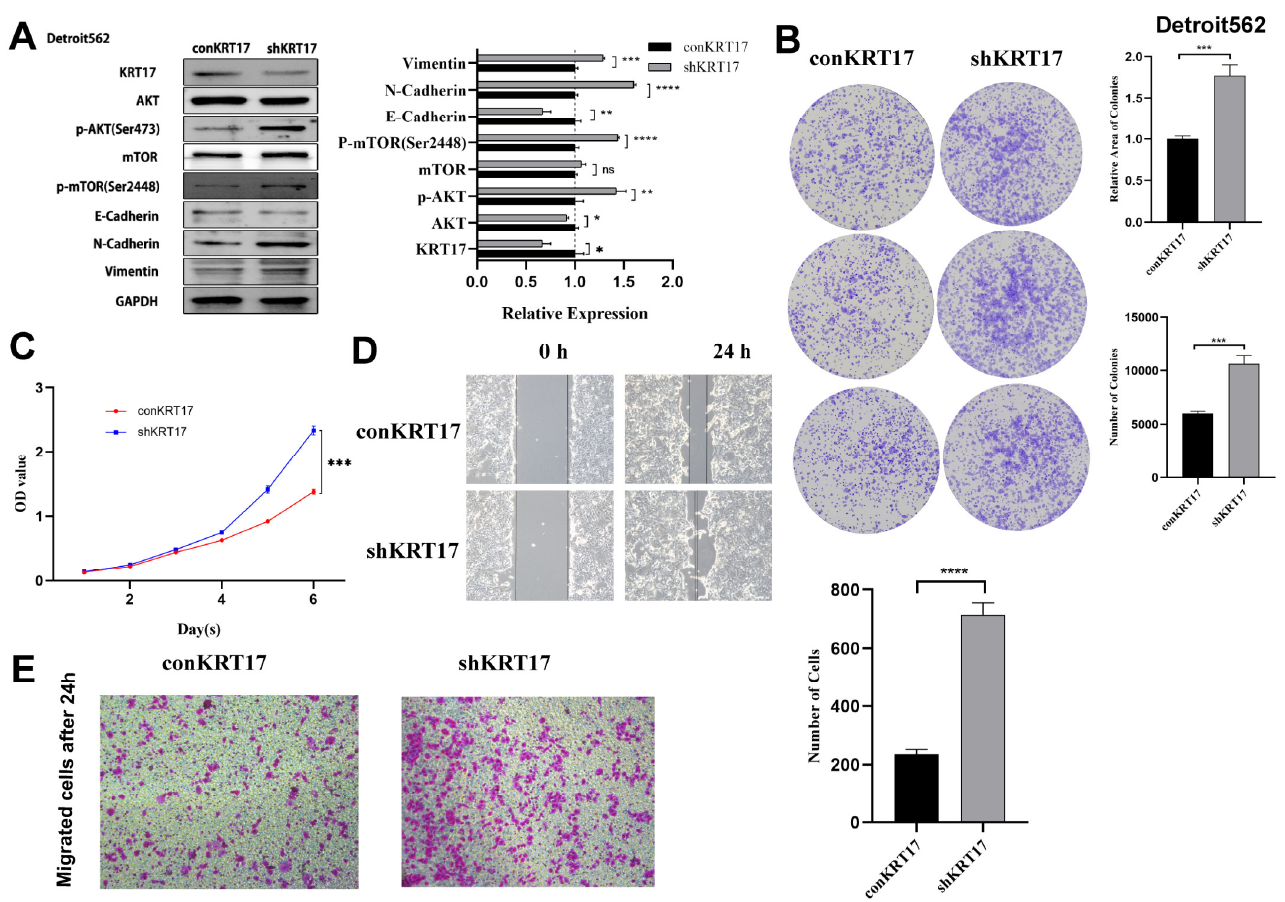
Figure 6. KRT17 knock down in Detroit562 cell line. ( A ) Phosphorylation levels of AKT and mTOR were significantly increased, E-cadherin was downregulated, N-cadherin and VIM was upregulated in the knockdown group versus the control group. ( B ) Colony formation assay showed that the number of colonies was not significantly different after knockdown of KRT17; however, the relative area was significantly increased. ( C ) CCK-8 assay showed that the cell proliferation was increased after knockdown of KRT17. ( D , E ) Transwell experiments showed that knockdown of KRT17 signif- icantly increased the migratory ability of tumor cells. The figures were captured under 10 × 10 mi- croscope. * p < 0.05; ** p < 0.01; *** p < 0.001; **** p < 0.0001; ns no significance. The uncropped bolts are shown in Supplementary Materials File S1.